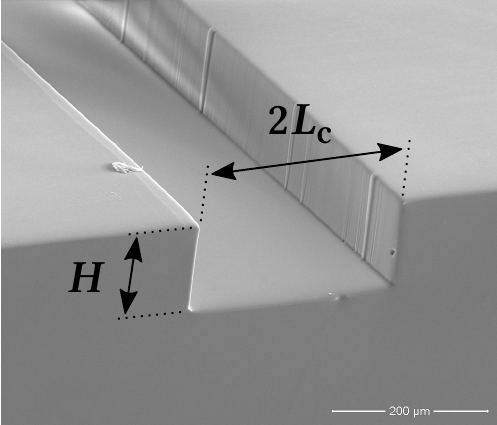
Figure 1. Scanning electron microscopy (SEM) image of the microchannel 270 µ m × 100 µ m cross-section: 2 L c is the channel width and H is the channel height, L c being its characteristic